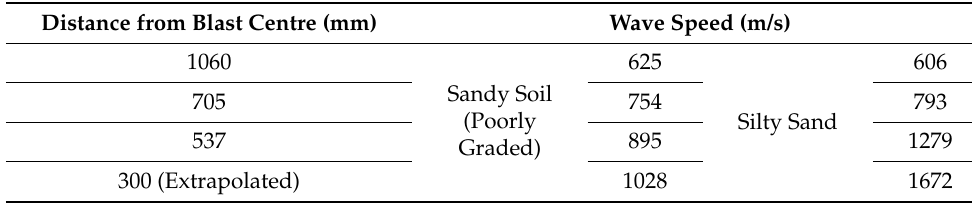
Table 1. Wave speeds calculated from TOA data from Ehrgott [41], extrapolated to 300 mm for equivalence with CoBL data.